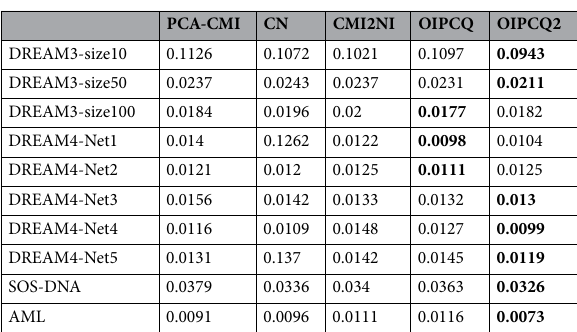
Table 8. Standard Deviation for F-measure based on removing 10% of the samples. Best results are indicated in bold.